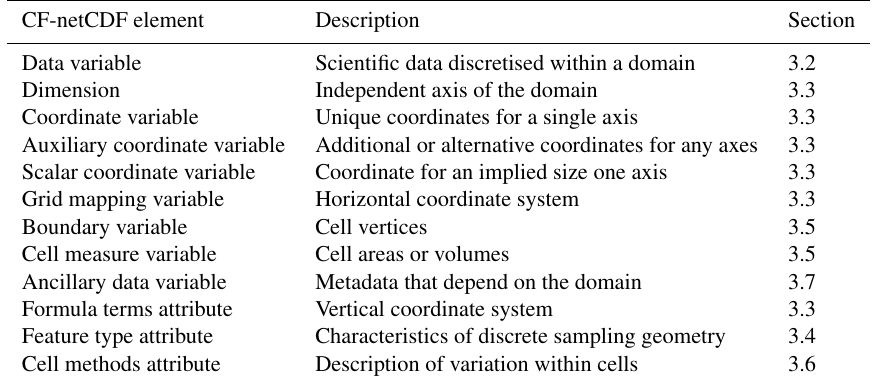
Table 2. The elements of the CF-netCDF conventions, a brief description of each, and the section in which it is described in more detail. The relationships to netCDF entities are shown in Fig.